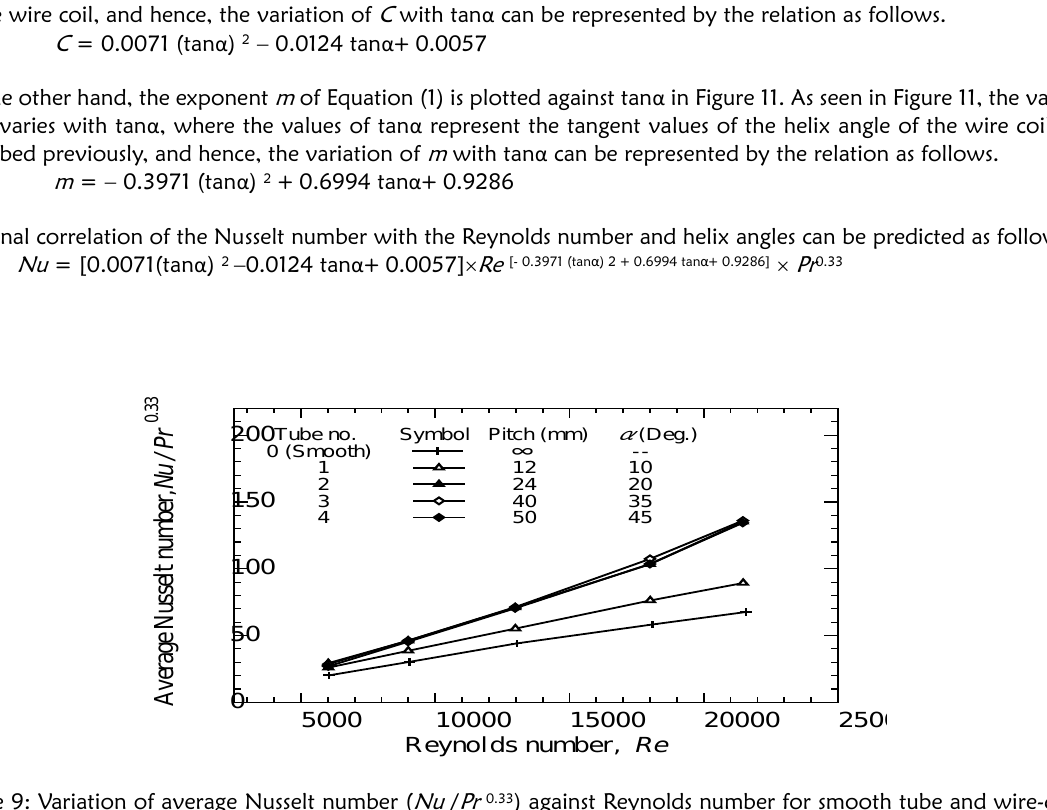
Figure 9: Variation of average Nusselt number (Nu /Pr 0.33 ) against Reynolds number for smooth tube and wire-coil inserted tubes.